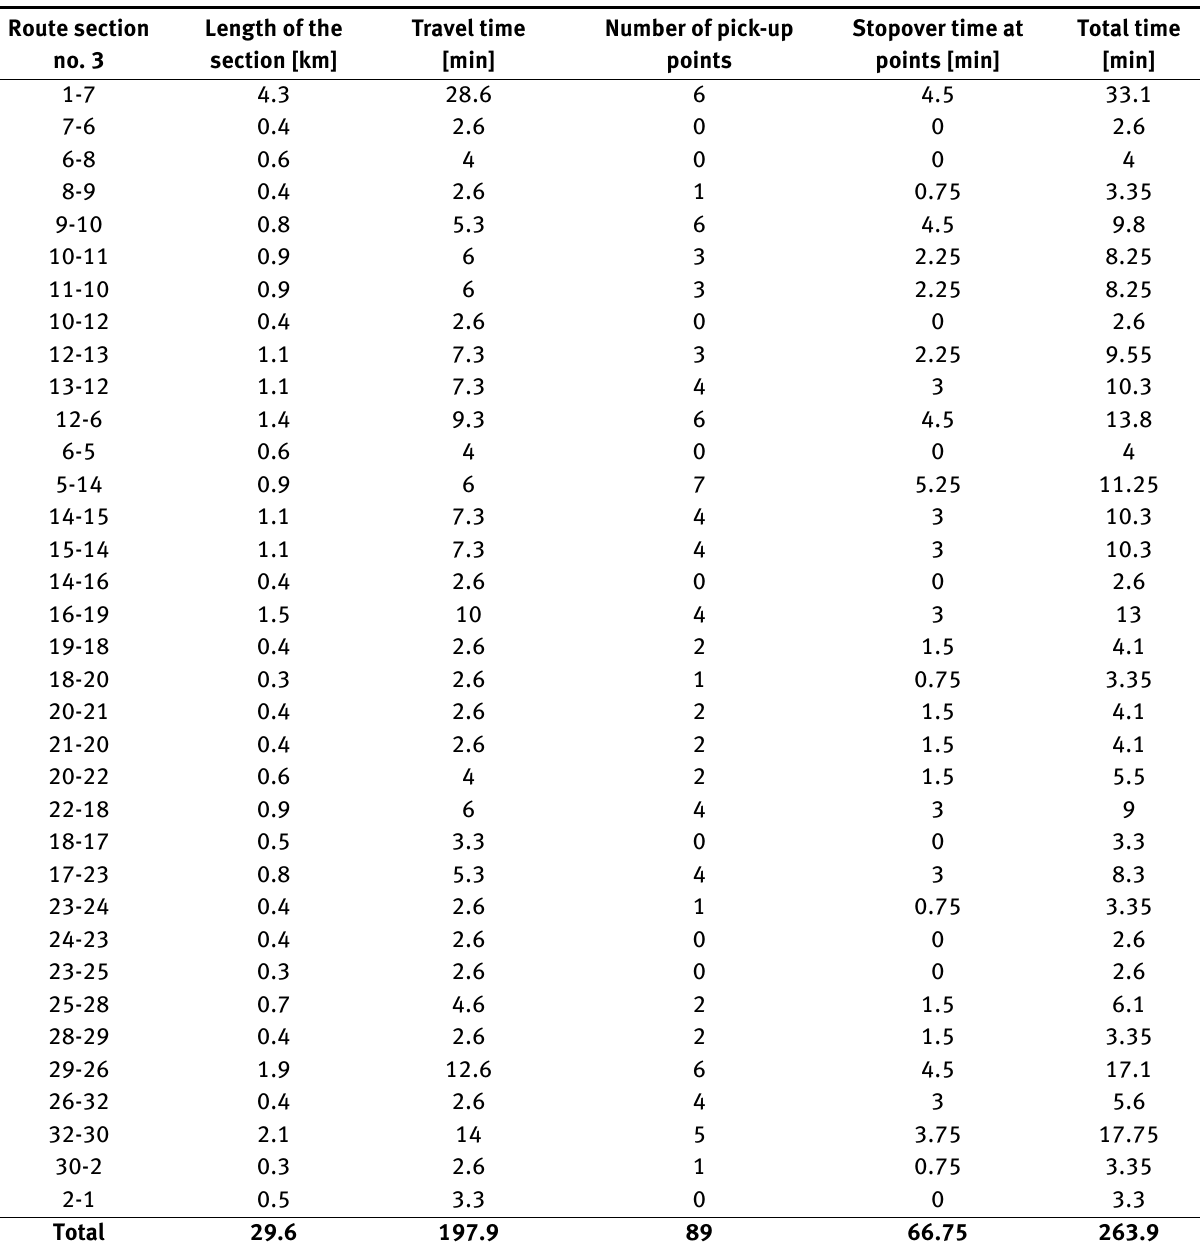
Table 4: Summary of the route of mixed waste collection after optimization by means of a decision model Route section